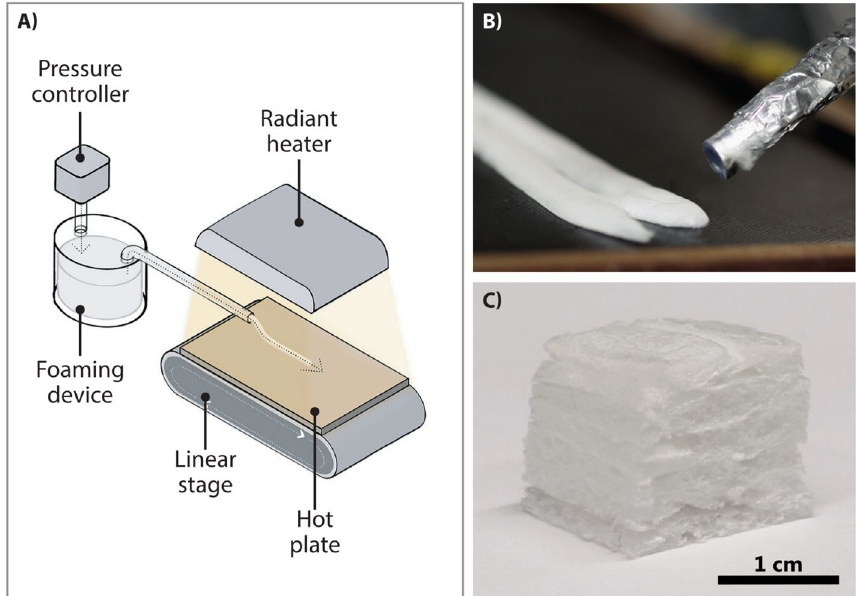
Figure 1. Making wood-like foams. ( A ) Schematic view of the setup showing how the foam is ejected from the foaming device by the controlled air pressure to the hot plate. The linear stage moves as the foam is ejected, creating a solid rod like object that is dried by the radiant heater. ( B ) Close view of two rods created by two passes of the cylindrical extruder head. ( C ) Final foam block cut into a cube for compression